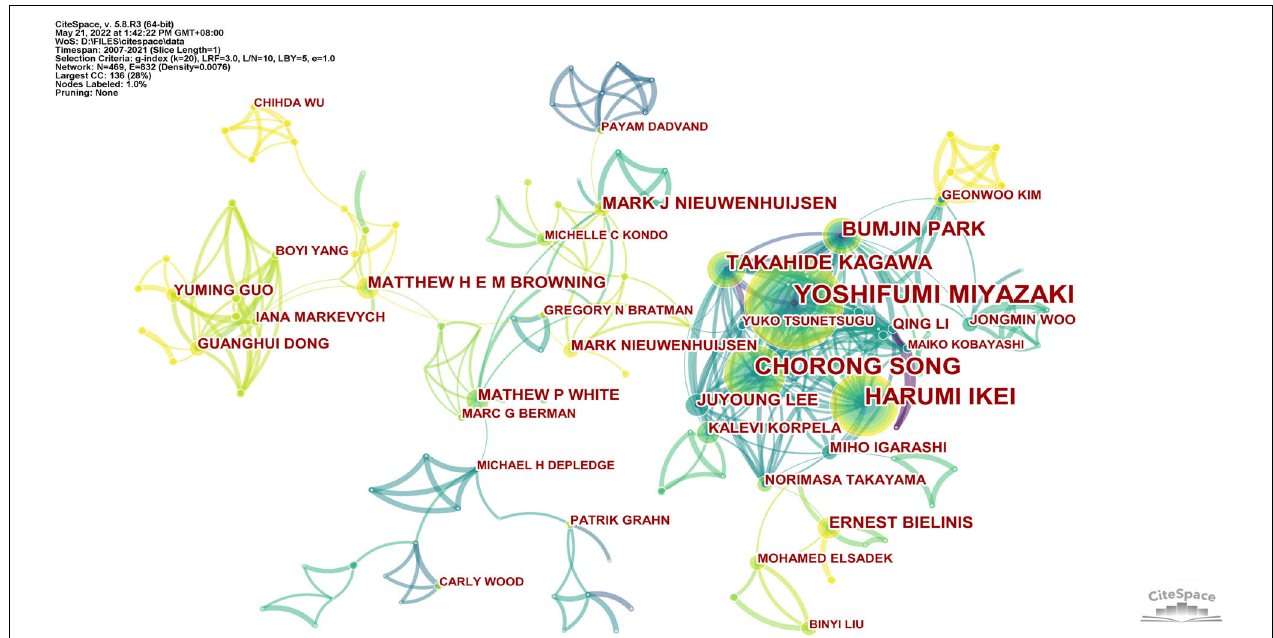
FIGURE 3 | The collaboration network of authors that published studies on forest